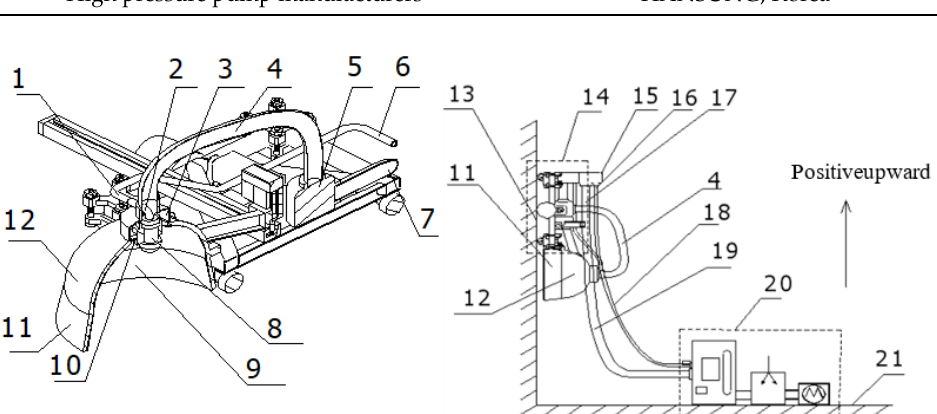
Figure 5. Spraying robot system 2D model design: 1. Nozzle feed pipe; 2. Paint supply pipe; 3. Vac- uum recovery cavity; 4. Vacuum recovery tube; 5. Recovery heater; 6. Paint feeding pipe; 7. Heater recovery tube; 8. Nozzle; 9. Protective; 10. Paint mist recovery hole; 11. Protection cover and seal; 12. The protective cover; 13. Ship plate; 14. The frame of the robot; 15. Free rotation connector; 16. Rotary feed pipe joints; 17. Rotation recovery pipe joint; 18. The feed tube; 19. The recovery of spray robot; 20. The recovery of feeding pipe and ground system; 21. Dock ground.